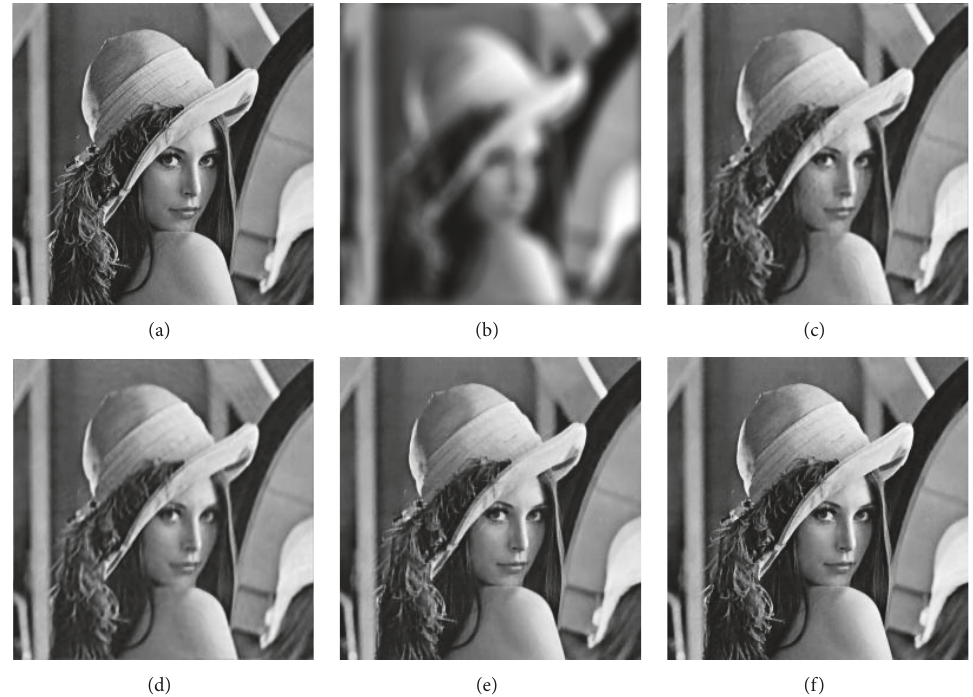
Figure 9: Restoration results of the Lena image with out-of-focus blur kernel. (a) Original image; (b) blurred and noisy image; (c) image recovered by FTVd; (d) image recovered by TGV; (e) image recovered by TVframe; (f) image recovered by TGVframe.